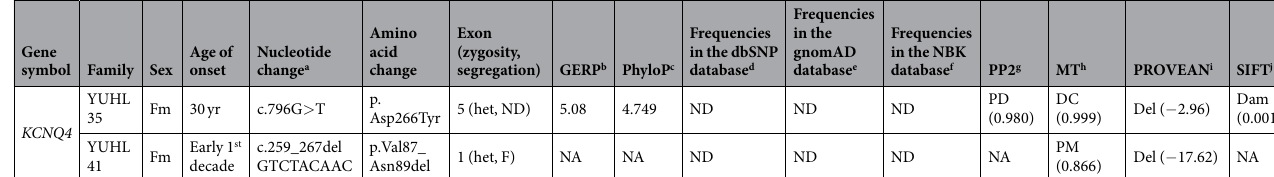
Table 1. Mutations in KCNQ4 detected in individuals with nonsyndromic hearing loss by WES. Abbreviations are as follows: Dam, damaging; DC, disease causing; Del, deleterious; F, heterozygous mutation identified in the father; Fm, female; het, heterozygous in the affected individual; M, heterozygous mutation identified in the mother; MT, Mutation Taster; NA, not applicable; ND, no data or DNA available; PD, probably damaging; PM, polymorphism; PP2, PolyPhen-2 prediction score Humvar; PROVEAN, Protein Variation Effect Analyzer; SIFT, Sorting Intolerant from Tolerant; SNP, single nucleotide polymorphism; yr, years; YUHL, Yonsei University Hearing Loss cohort. a cDNA mutations are numbered according to the human cDNA reference sequence NM_004700.3 ( KCNQ4 ); + 1 corresponds to the A of ATG translation initiation codon. b Genomic Evolutionary Rate Profiling (GERP) score. b PhyloP100way_vertebrate score. d dbSNP database (http://www. ncbi.nlm.nih.gov/SNP). e genome Aggregation Database browser (http://gnomad.broadinstitute.org/). f National Biobank of Korea (NBK), Centers for Disease Control and Prevention. g PolyPhen-2 (PP2) prediction score HumVar ranges from 0 to 1.0; 0 = benign, 1.0 = probably damaging (http://genetics.bwh.harvard.edu/pph2/). h Mutation taster (http://www.mutationtaster.org/). i PROVEAN, (http://provean.jcvi.org/index.php). j SIFT,